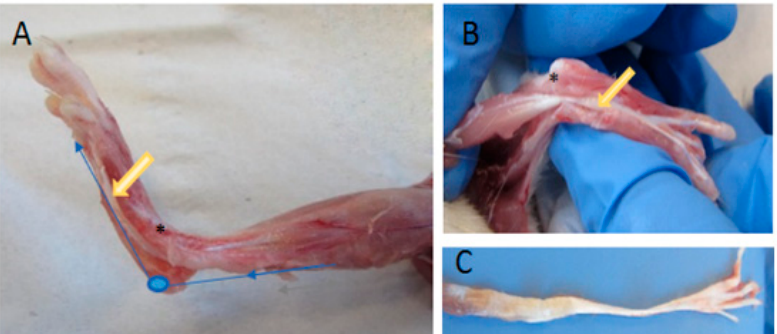
Figure 7. Preparation of a M. flexor digitorum longus tendon. After removing the gastrocnemius muscle, the flexor digitorum longus was exposed ( A and B ). The synovium of was cut down and tendon and muscle were mobilized ( B ). For cultivation of the tendon in the bioreactor, the muscle was removed ( C ). The blue line indicates the pathway of the tendon; the yellow arrow, the traction area; an asterisk shows the intrasynovial gliding area.